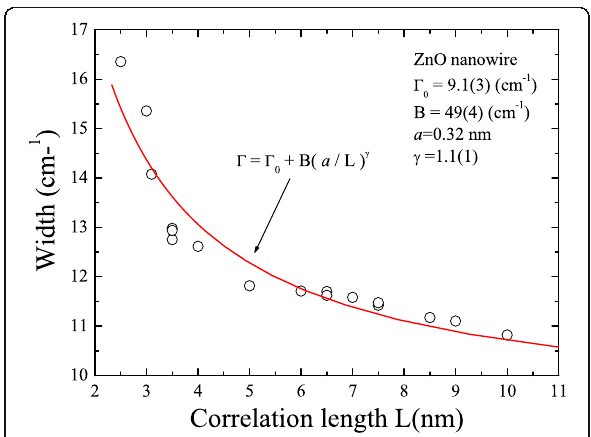
Fig. 5 Plot of calculated values of correlation length versus profile width. The red solid curve indicates the fit of the data to the theoretical curve for a decay